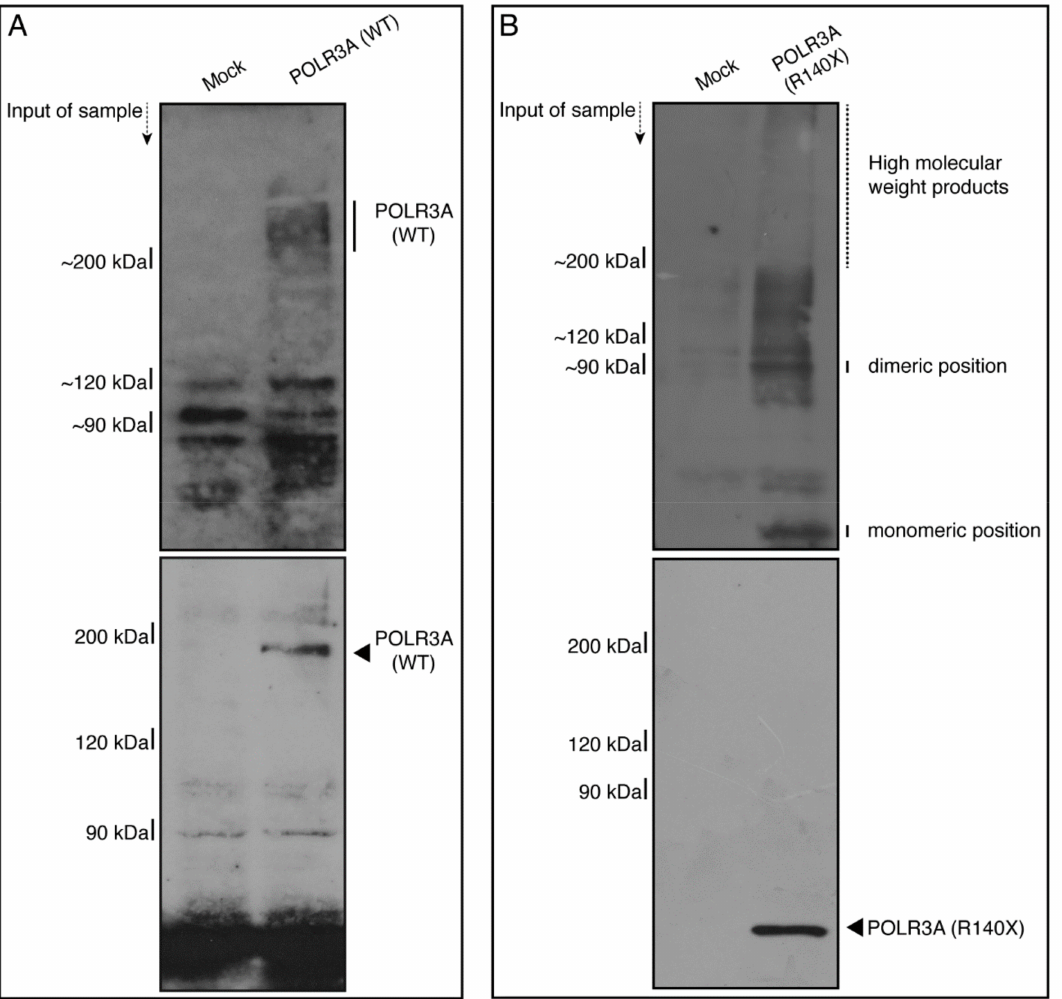
Figure 8. The POLR3A mutant proteins, but not the wild type proteins, exhibit dimeric and high- molecular-weight structures in non-denaturing polyacrylamide gel electrophoresis. ( A , B ) The lysates of FBD − 102b cells transfected with an empty vector or with a plasmid encoding the wild type (WT) or POLR3A R140X construct were subjected to non-denaturing (upper images) and denaturing (lower images) polyacrylamide gel electrophoresis and detected using immunoblotting. The positions corresponding to the molecular weight of the wild type POLR3A monomer or the POLR3A R140X monomeric or polymeric (including high-molecular-weight products) structures are